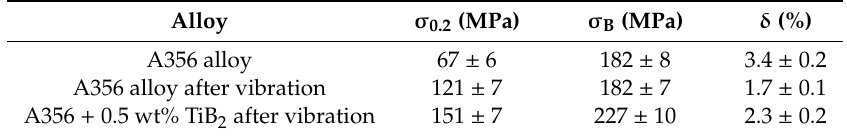
Table 1. Mechanical properties of an initial A356 alloy and composites based on it, containing titanium diboride particles before and after vibration treatment.